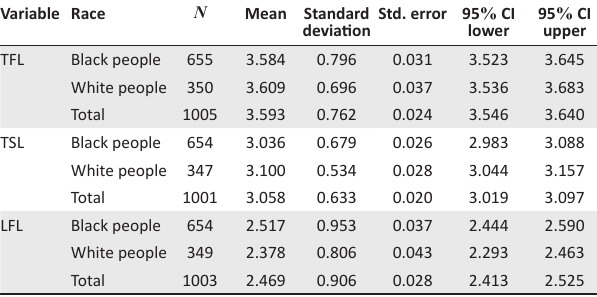
TFL, transformational leadership; TSL, transactional leadership; LFL, laissez-faire leadership.